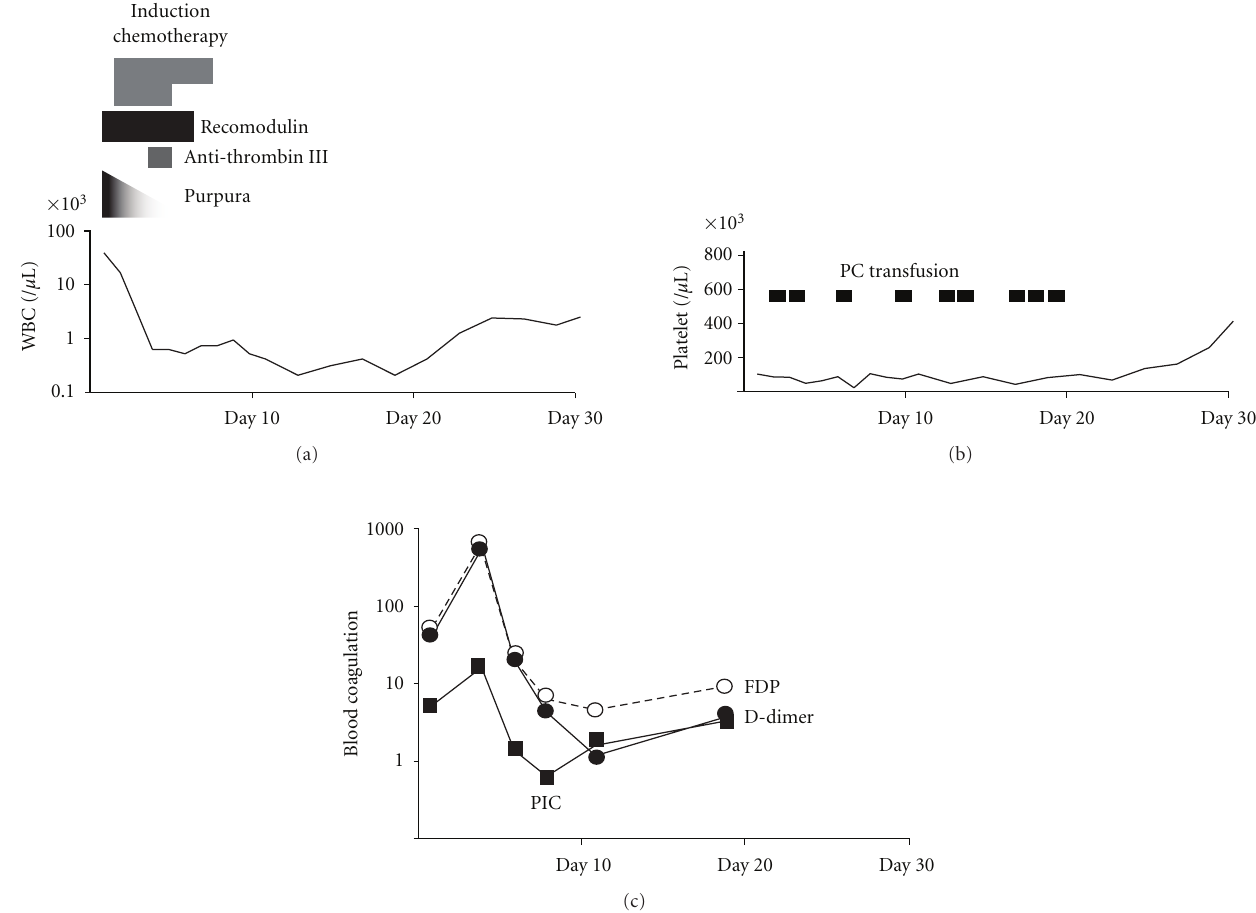
Figure 2: Clinical course. Disseminated intravascular coagulation, DIC, was diagnosed on February 5 in 2010 (the 1st hospital day, day 1), then 25,600 units of recombinant thrombomodulin α (Recomodulin) were administered for 6 days. Additional antithrombin III agent was also supplied on days 4 and 5. Several DIC markers rapidly improved on day 6, and bleeding tendency controlled e ff ectively after Recomodulin administration. Adequate times of platelets transfusion (PC transfusion) were needed to overcome DIC or bone marrow suppression after chemotherapy. Patient achieved the 1st complete remission, CR on Mar. 11 in 2010 (day 35). Then, patient has completed 4 courses of consolidation chemotherapy, and the 1st CR has maintained until the present